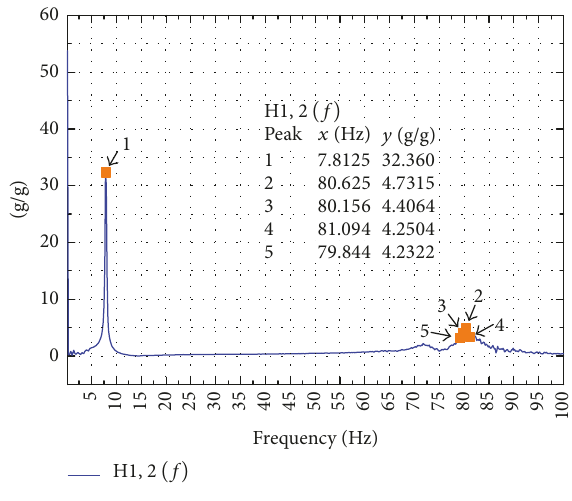
Figure 5: Frequency response function.